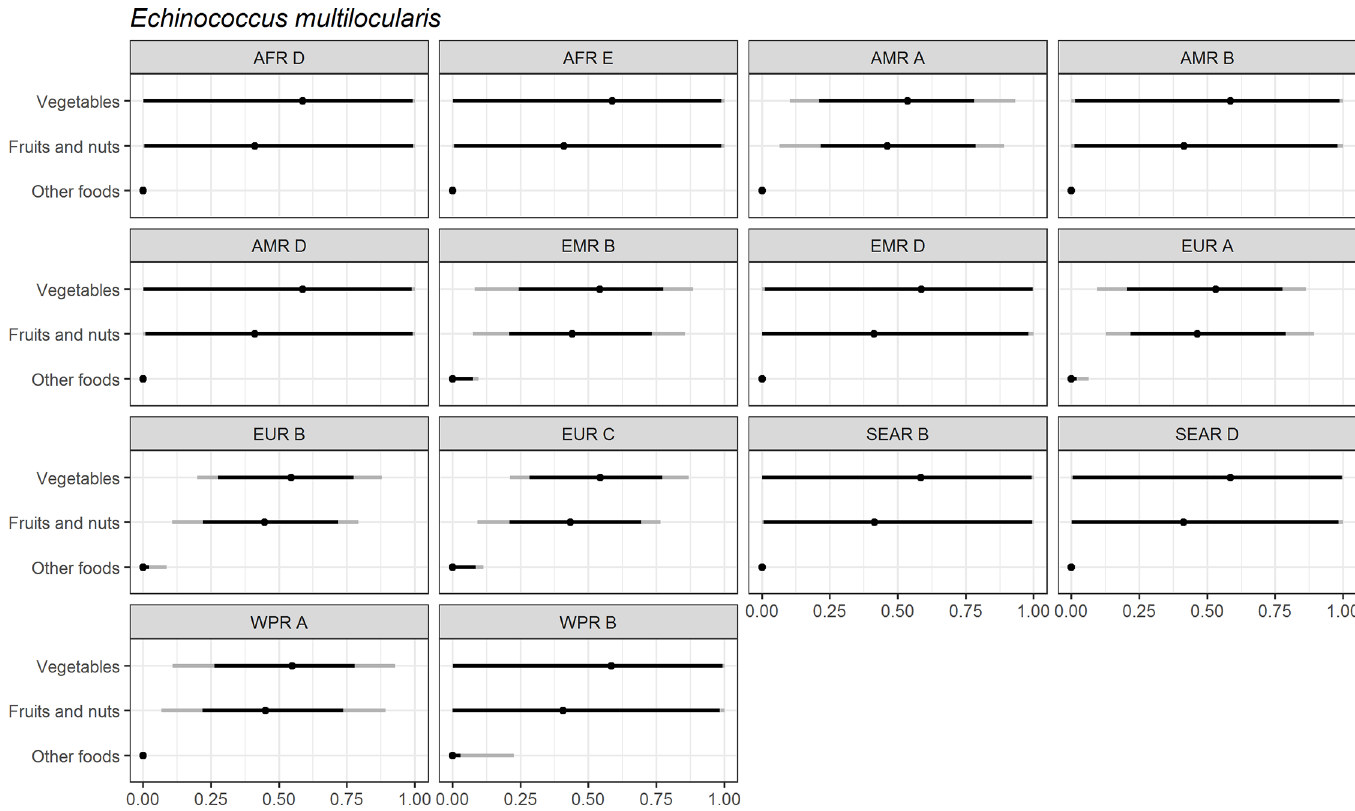
Fig 7. Echinococcus multilocularis . Proportion of foodborne disease attributable to specific foods: Median estimate, and 90% and 95% uncertainty intervals by parasite and subregion. “Small ruminants’ meat” was listed as “Goat, lamb and other small ruminants’ meat” in the expert elicitation instrument. The X-axis labelsare percentages. The dot represents the medianestimate; the dark black line, the 90% uncertaintyinterval; and the gray line the 95% uncertaintyinterval.